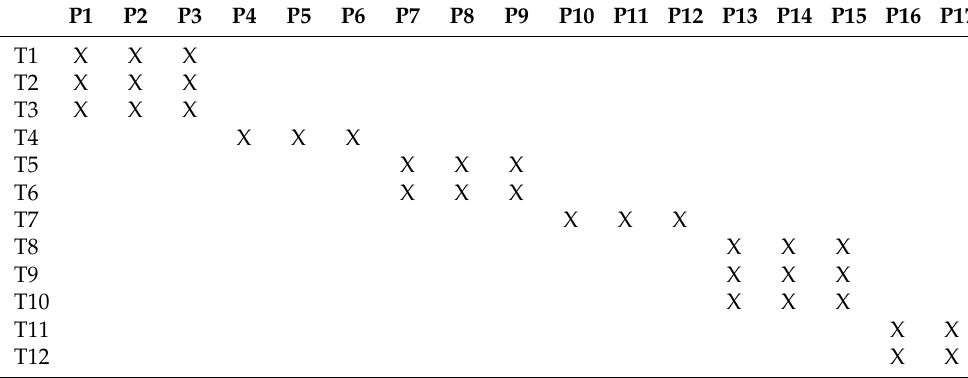
Table 6. Pairs of groups used in the first approach of the